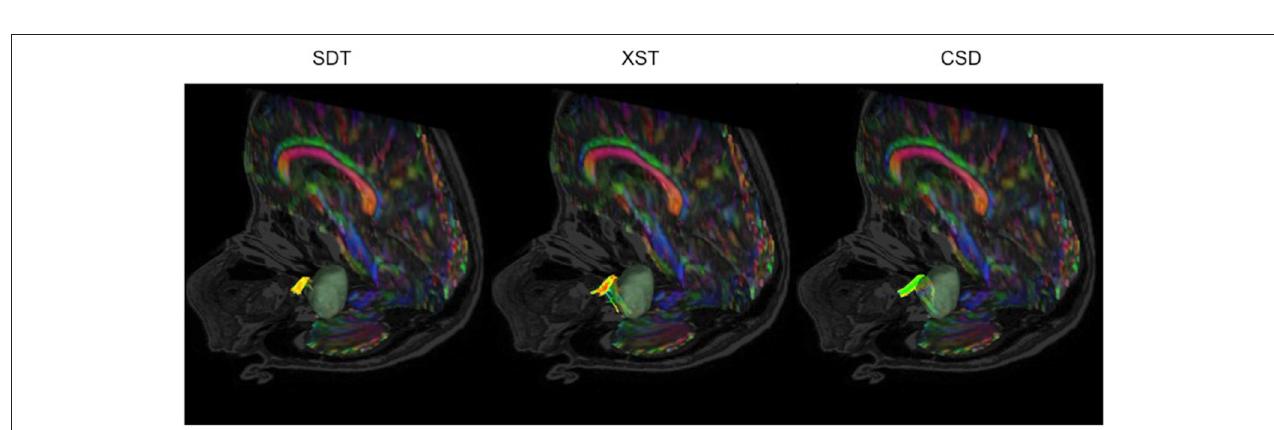
FIGURE 6 | CN VII/VIII generation from all three reconstruction methods in the same patient–P08. SDT could not show CN VII/VIII curving around tumor to anterior surface. However, CSD-based tractography produced more spurious fibers. Single Diffusion Tensor Tractography (SDT), EXtended Streamline tractography (XST), Streamline tractography on fiber orientation distributions (FODs) derived from constrained spherical deconvolution (CSD). Fibers are displayed from a superior-anterior perspective toward the brainstem. Images are displayed on a mixed anatomical-tensor model. The mixed anatomical-diffusion tensor model represents the tensor map being overlaid on a T1 anatomical image.